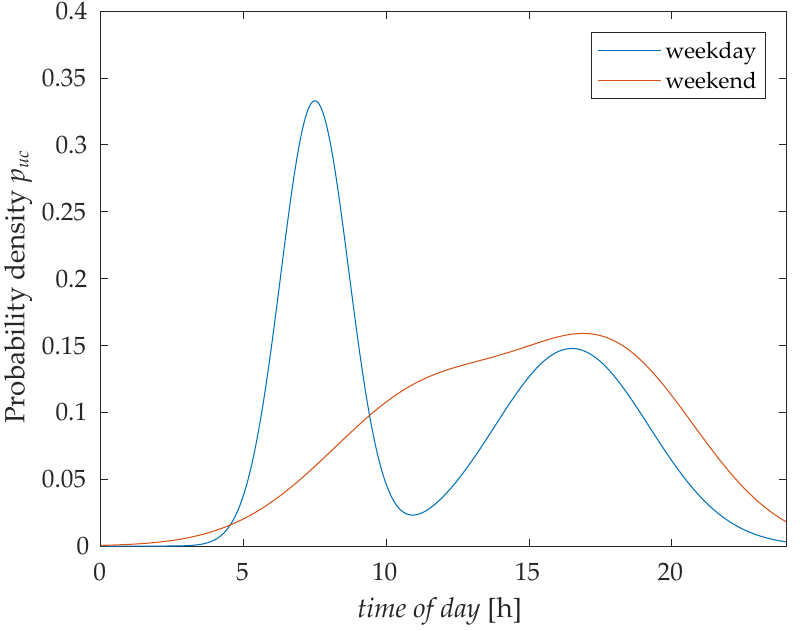
Figure 4. Probability density functions of plug-in times. Table 1. Sets of probabilities for within and beyond average charging